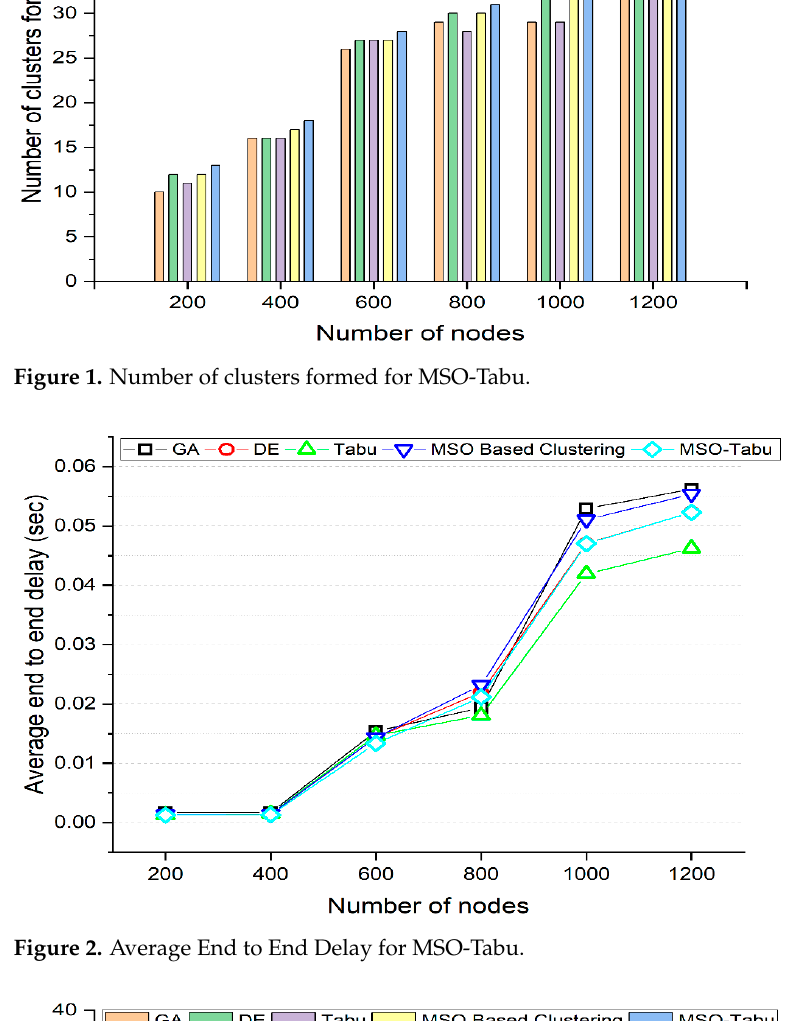
Figure 2. Average End to End Delay for MSO-Tabu.